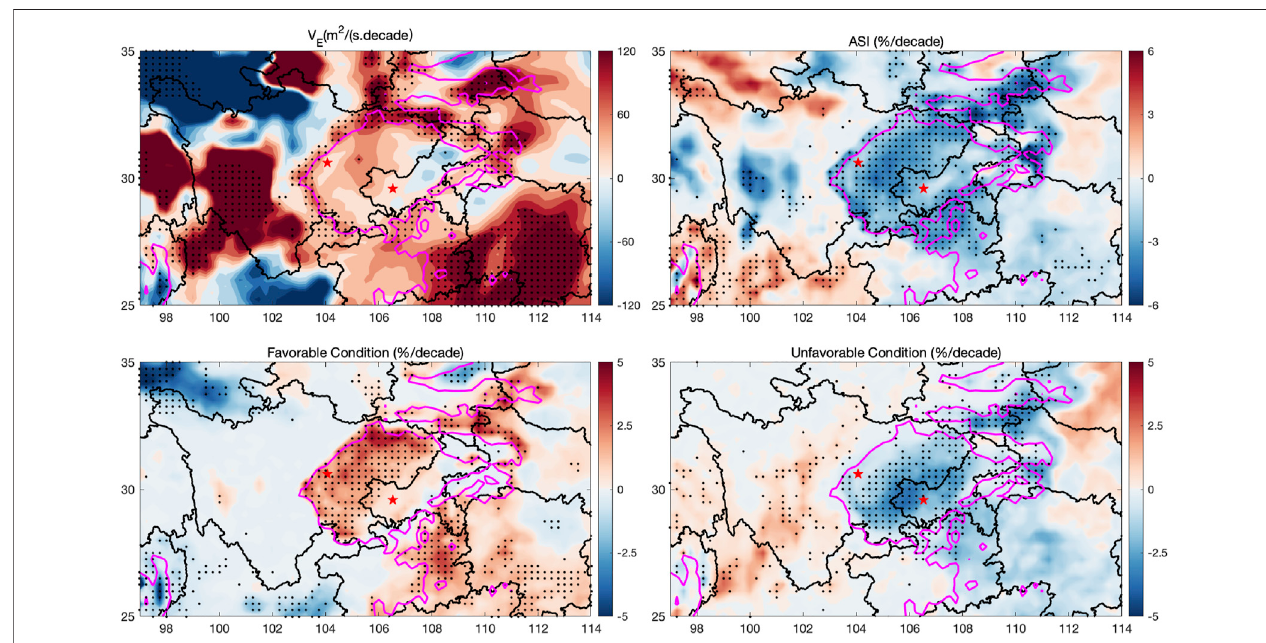
FIGURE7| Distributionofthelong-termtrendsofV E ,ASI,andfavorableandunfavorableconditionfrequenciesduringthewintersfrom1979to2019intheSichuan Basin. Dots mark the signi fi cance at 5% of the linear trends based on least square method.